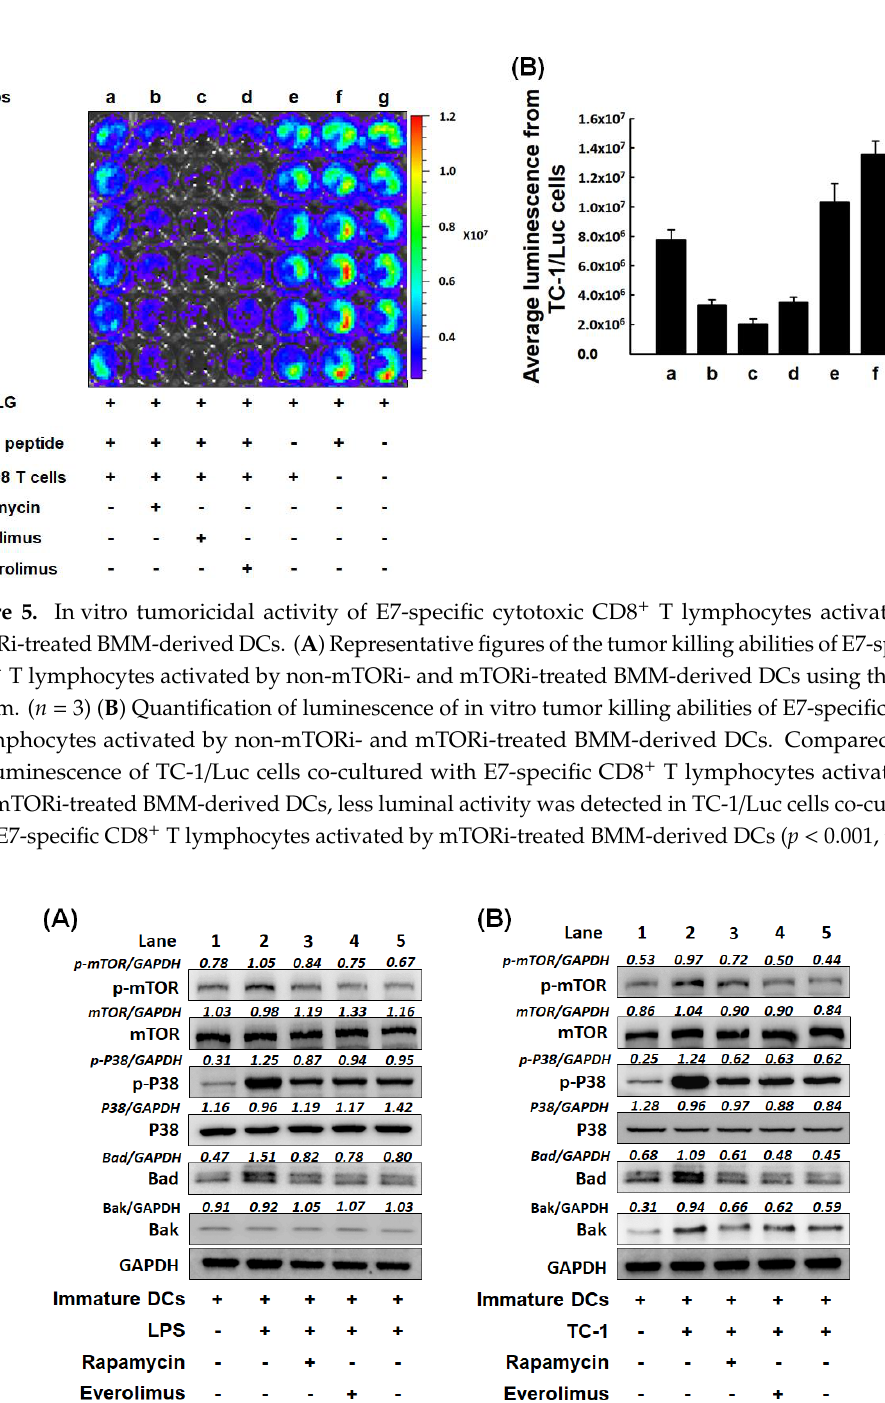
Figure 6. Western blotting of signaling pathways of BMM-derived DCs treated with mTORi. ( A ) The